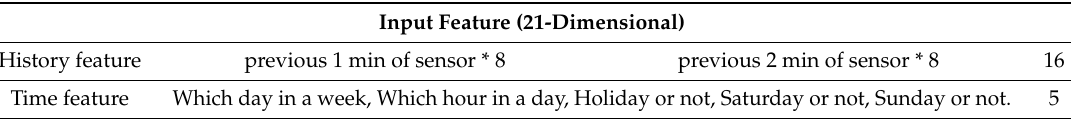
Table 1. Input features obtained from noise sensor